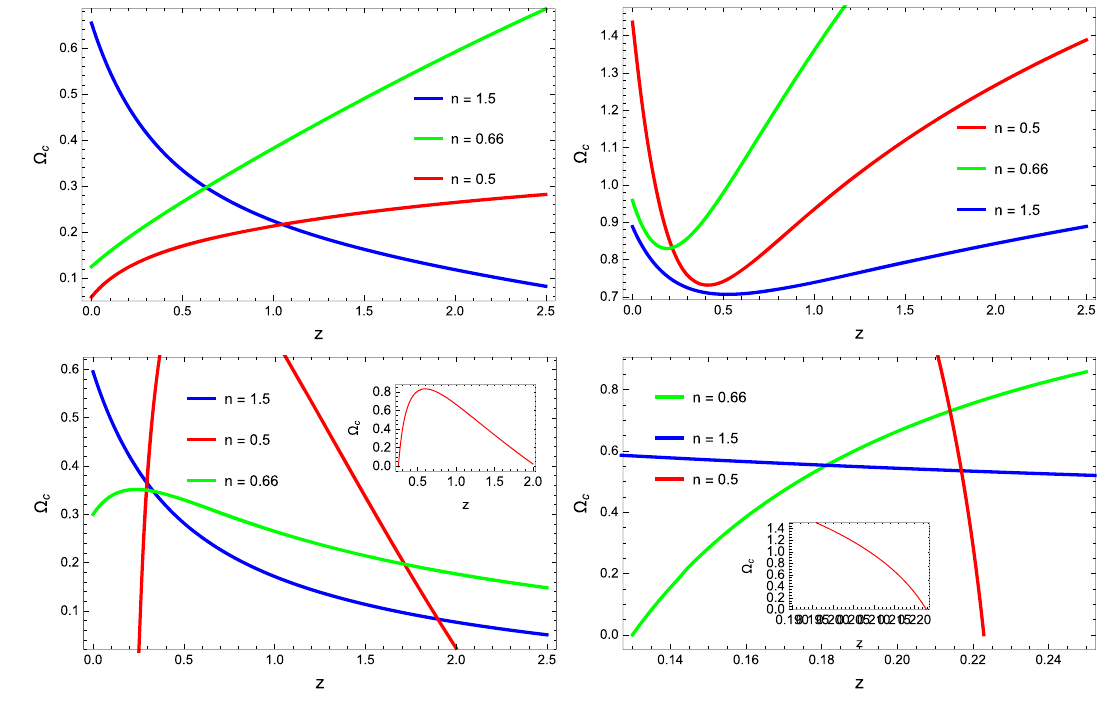
Fig. 7 Evolution of dark energy density parameter versus z